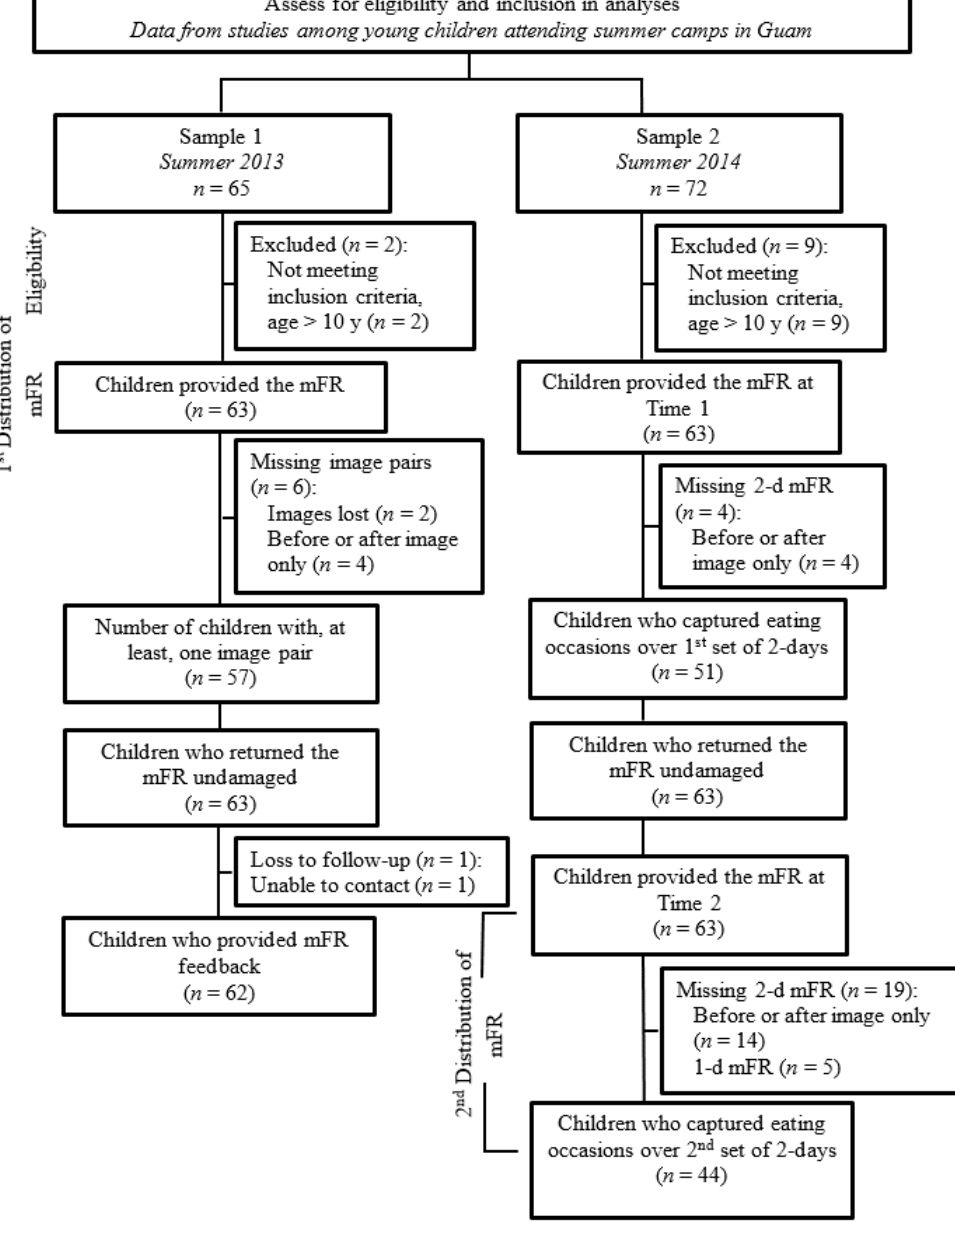
Figure 1. Assessment of eligibility for inclusion in analyses among children attending summer day-camps in Guam during summer 2013 (Sample 1) and during summer 2014 (Sample